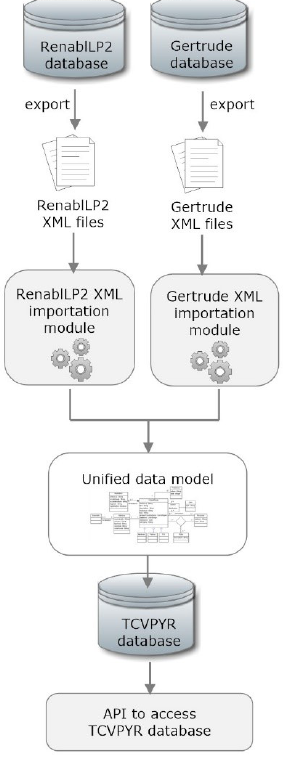
Figure 4. Data merge